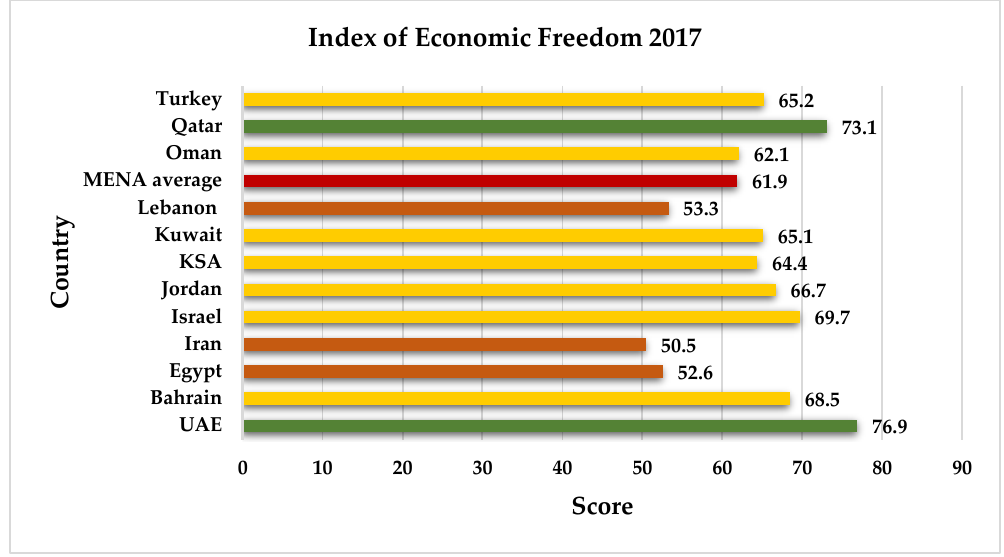
Figure 13. Index of Economic Freedom for the countries of interest within the MENA region in 2017. Countries are categorized as follows: (0–49.9) are repressed country, (50–59.9) are mostly unfree country, (60–69.9) are moderately free country, (70–79.9) are mostly free country, and (80–100) are free country. Note: not listed countries implies data unavailability. The data is acquired from Miller and Kim [75].